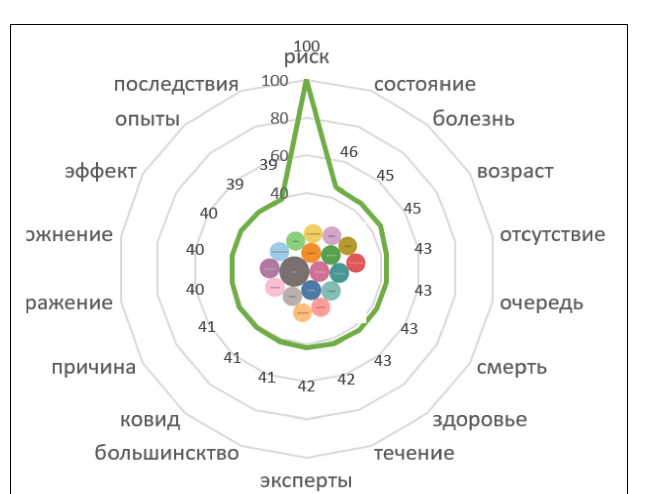
FIGURE 9 | Associative network of the stimulus Risk